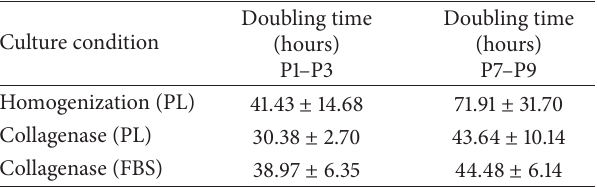
Table 1: Population doubling time for early and late passages. Culture condition